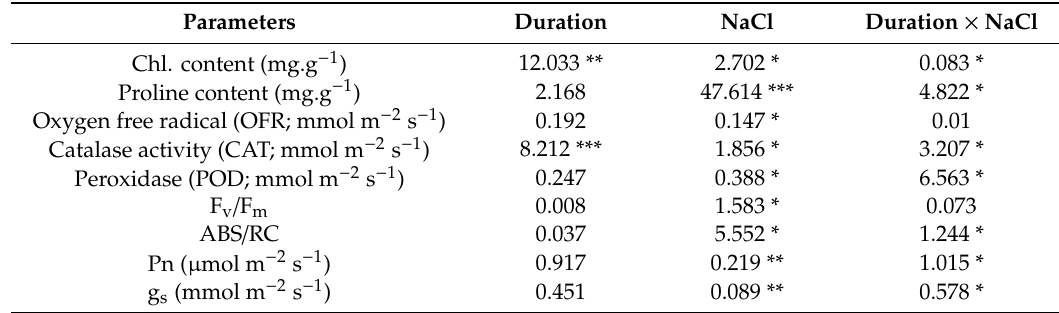
Table 1. Interactive e ff ects of salt stress magnitude and its duration on physiological level and the activities of antioxidant enzymes in alfalfa leaves subjected to 200 mM NaCl for 14 d, via two-way